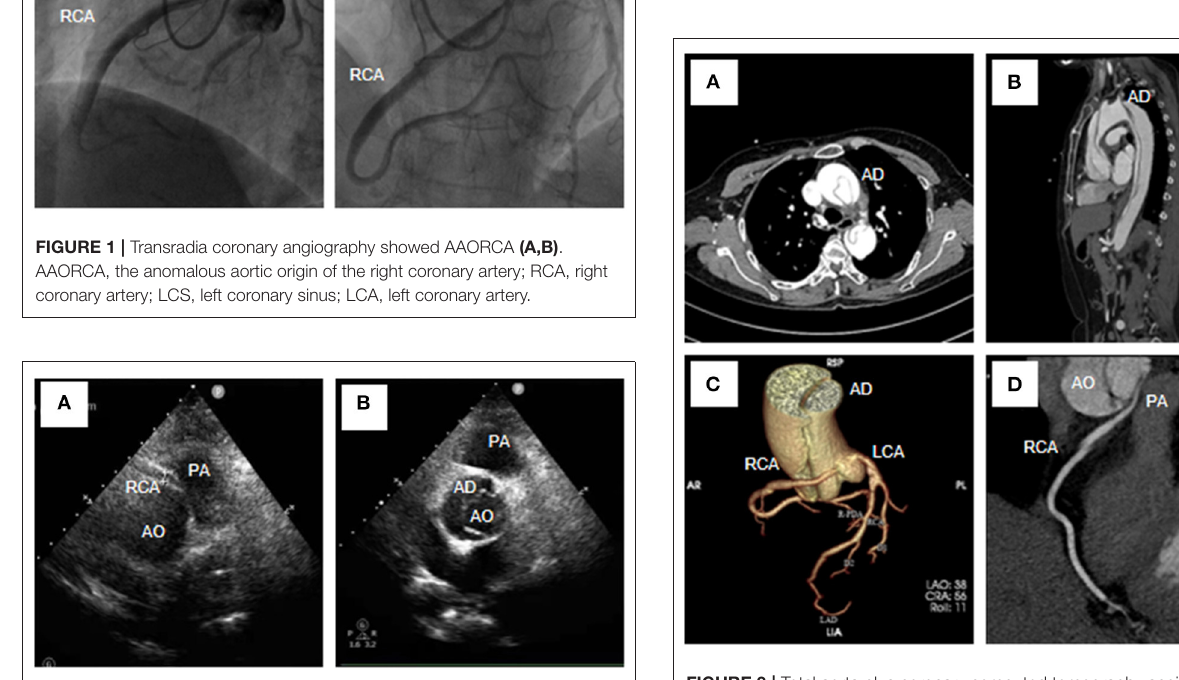
FIGURE 2 | Transthoracic echocardiography (Short-axis view at the great artery) revealed Stanford type A aortic dissection (A) , avulsion of the RCA, and the RCA originating from the left coronary sinus (B) . RCA, right coronary artery; AD, aortic dissection; AO, aortic; PA, pulmonary artery.